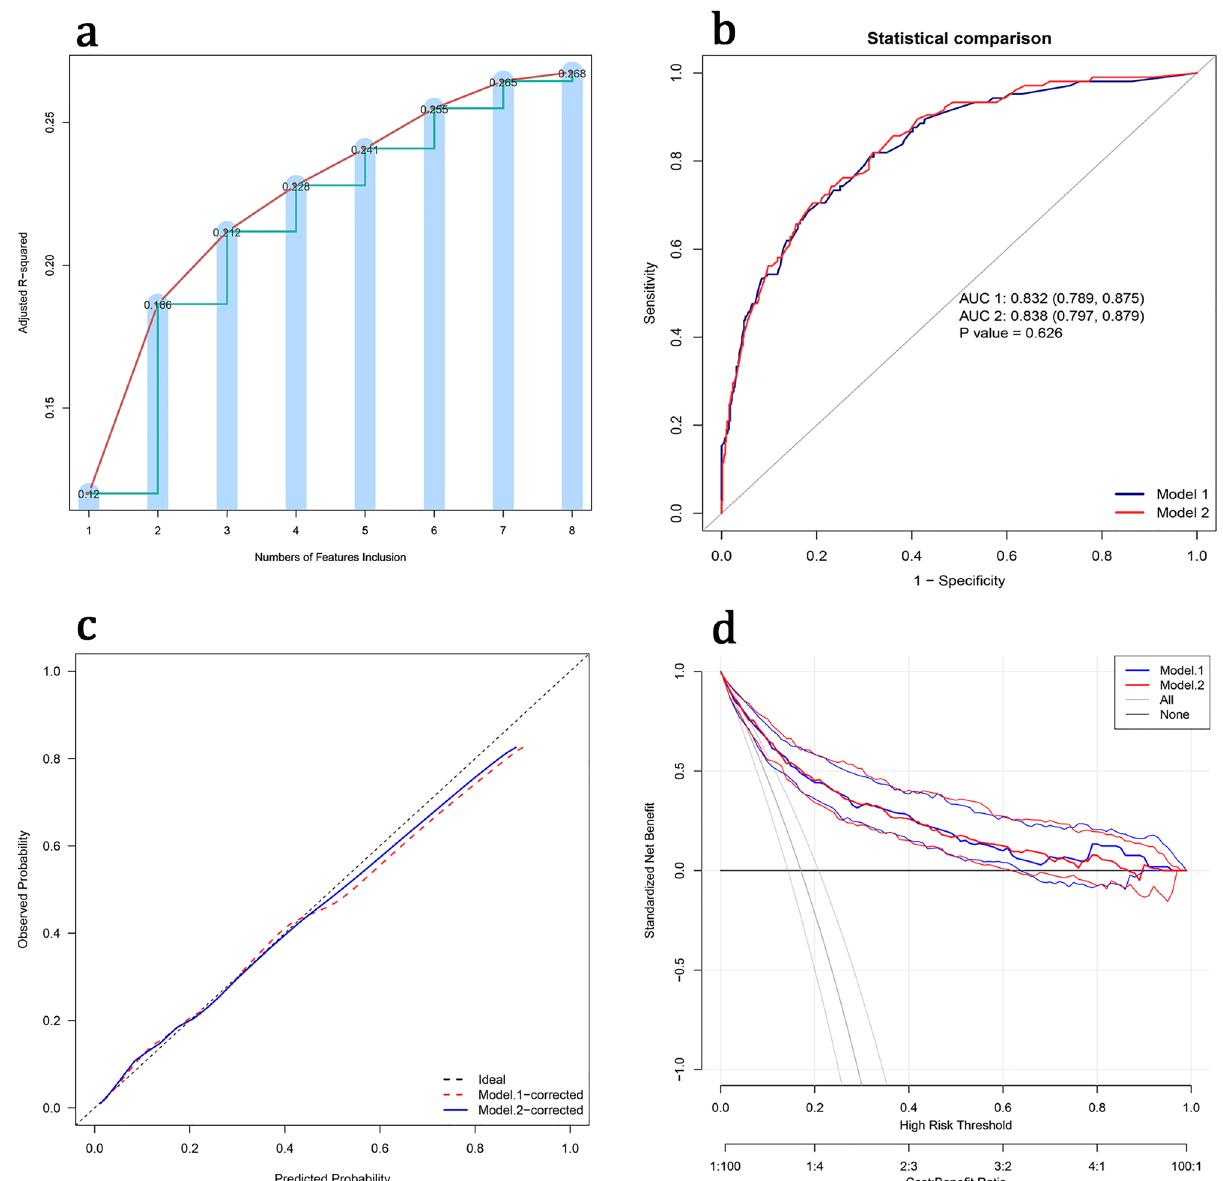
Figure 4. Comparison of different variable screening methods. ( a ) The abscissa represents the number of variables included, and the ordinate represents the value of adjusted R-square; when the number of variables is 8, the maximum adjusted R-square is 0.268. ( b ) Comparison of ROC curves between model 1 and model 2. ( c ) Comparison of calibration curves between model 1 and model 2. ( d ) Comparison of decision curves between model 1 and model